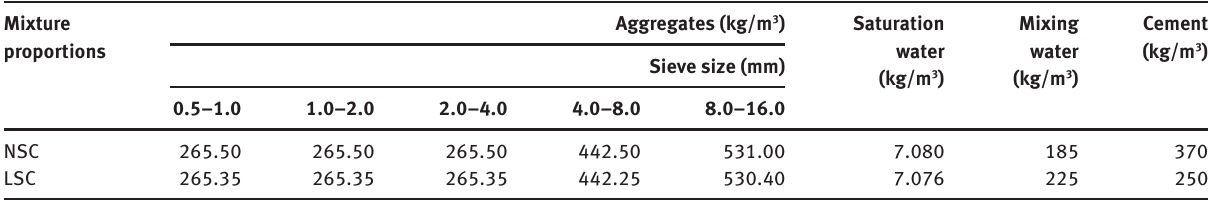
Table 2: Mixture proportions of normal strength concrete (NSC) and low strength concrete (LSC). Mixture proportions